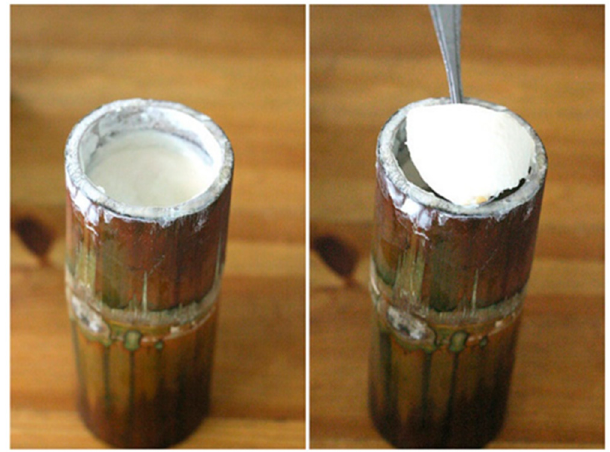
Figure 2. Dadih . The bamboo tube is used as the container during buffalo milk fermentation process. The resulting fermented buffalo milk— dadih has a smooth and glossy surface, even consistency, creamy-white color, pleasant aroma, and sour taste. Photo by: I. Soemardjan (CC BY-NC-ND 2.0, source: https://www.flickr.com/photos/94093643@N00/180430205 (accessed on 16 May 2021) and https://www.flickr.com/photos/indrani/180430424/in/photostream/) (accessed on 16 May 2021).